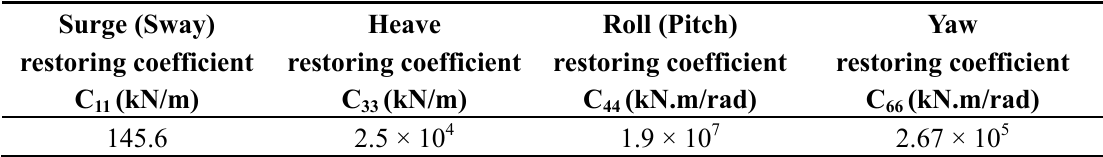
Table 6. Restoring coefficients of the mooring system.